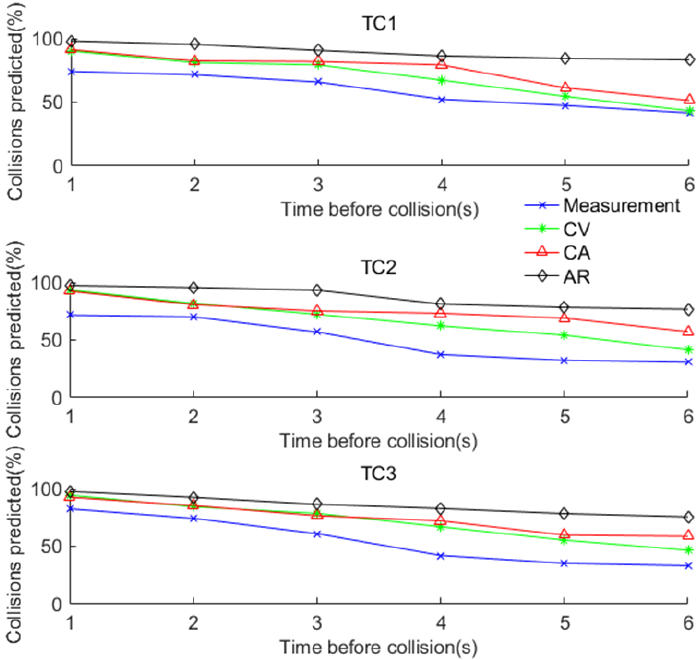
Figure 7. Collision prediction with various positioning methods.